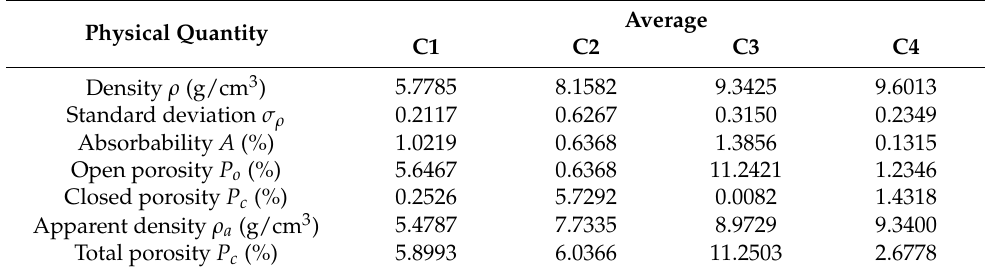
Table 7. Density-related measurement results and calculations of the porosity of the surface layers deposited (PPTAW) on structural low-alloy AISI 4715